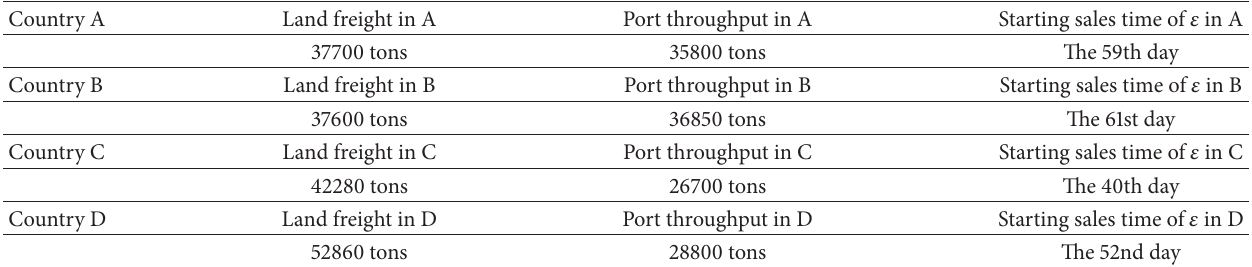
Table 13: Simulation results of freight volume and period in Scheme